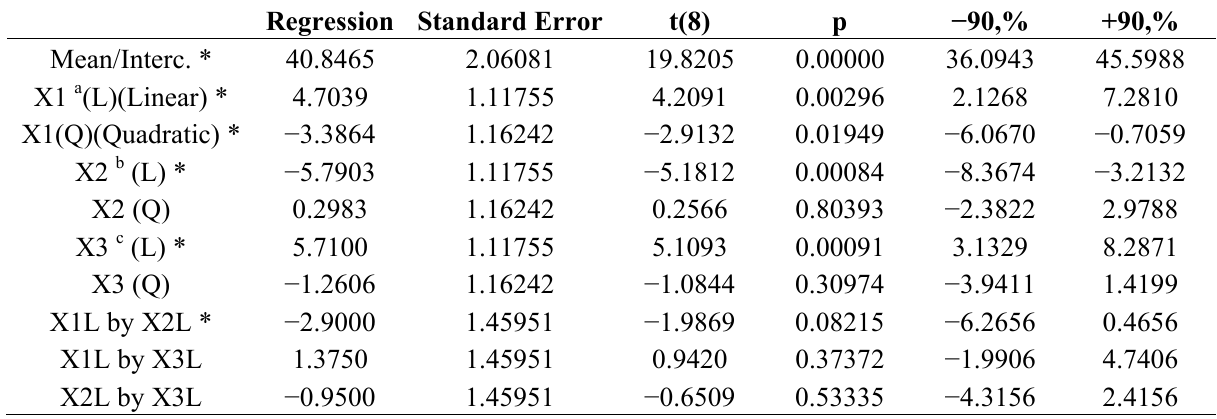
Table 3. Regression coefficients for lipase activity from the central composite design after 96 h of reaction. Mean/Interc.